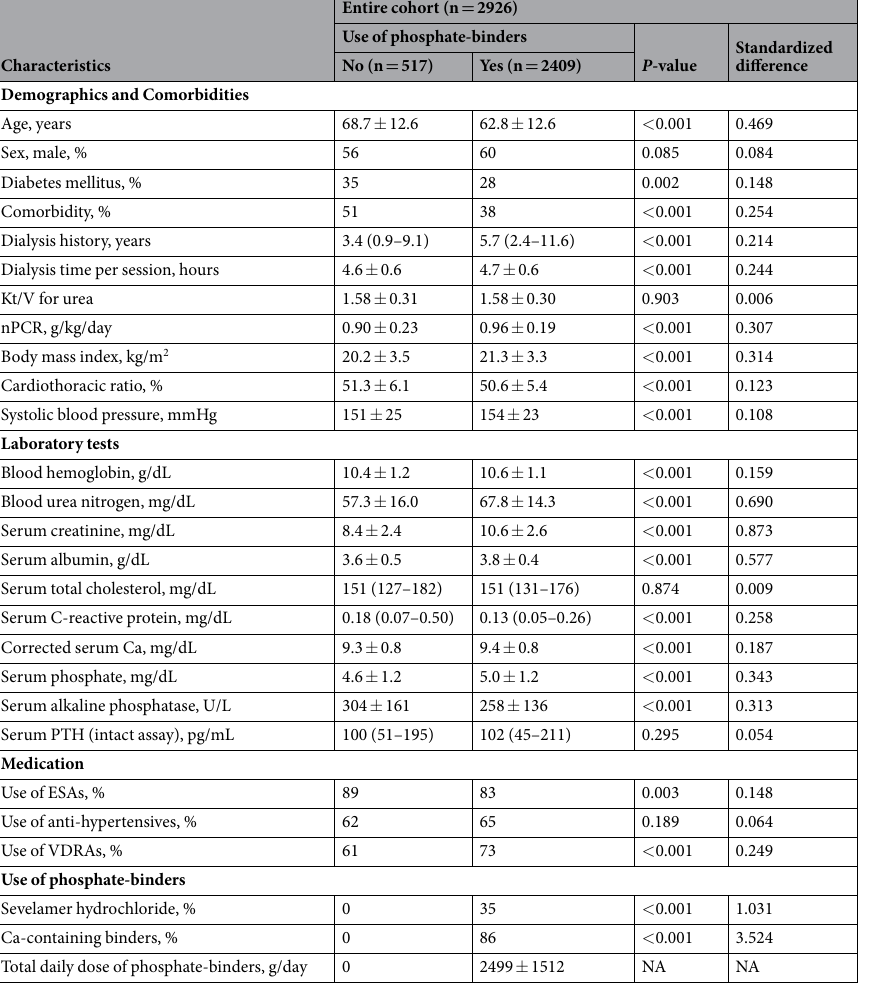
Table 1. Baseline clinical backgrounds of the patients treated with or without phosphate-binders. Data are expressed as the mean ± standard deviation, median (interquartile range), or percentage, depending on the nature of the variable. Unpaired t -test, chi-square test, or Wilcoxon sign-rank test was used to compare the two groups. Standardized difference was also calculated. A two-tailed P -value less than 0.05 was considered statistically significant. Comorbidity included history of cardiovascular events, bone fracture, and parathyroidectomy. Total daily dose of phosphate-binders was also calculated by adding daily dose of calcium carbonate and sevelamer hydrochloride and expressed as that of calcium carbonate. In the present study, Phosphate binding capacity of 750 mg of sevelamer hydrochloride was regarded equivalent to that of 500 mg